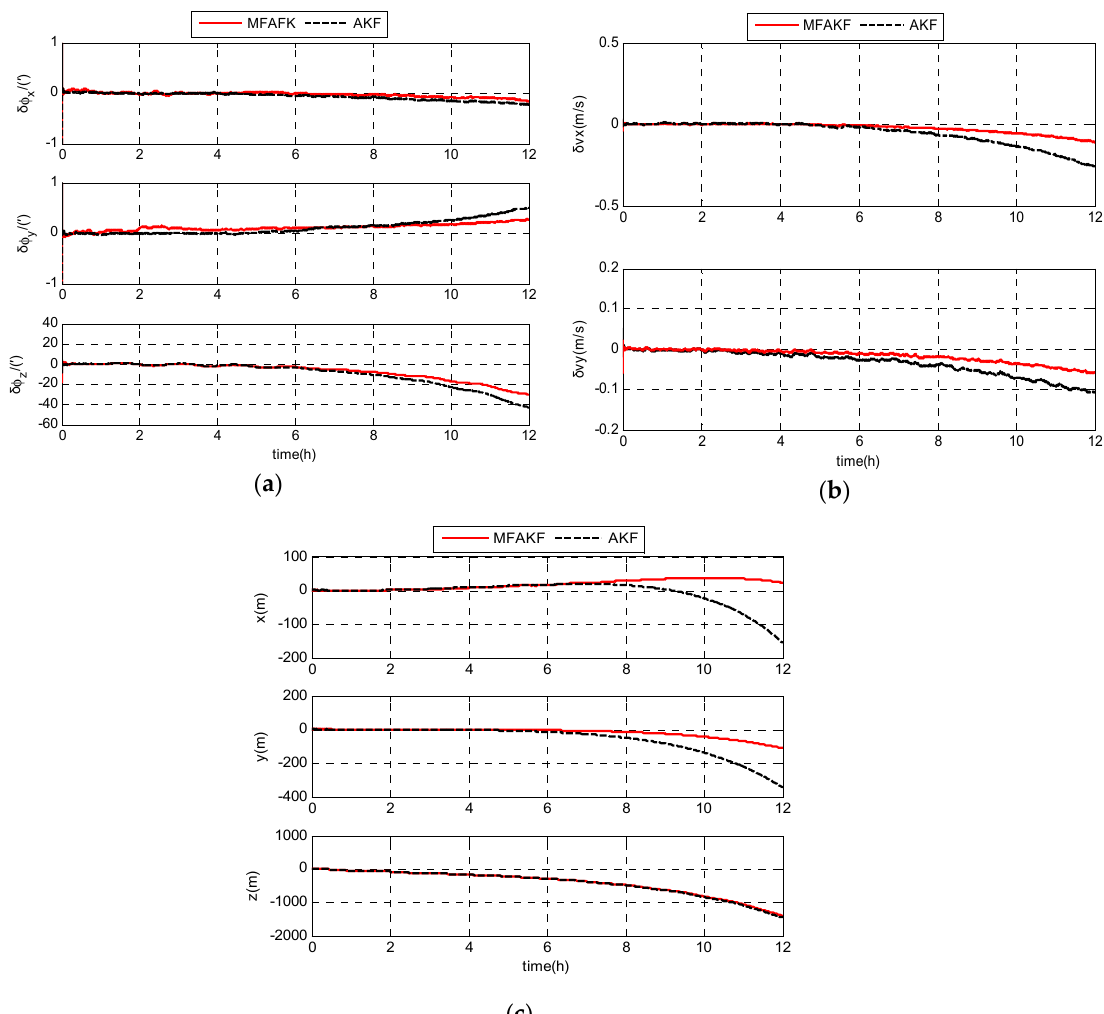
Figure 9. Experimental results of SODINS based on MFAKF and AKF: ( a ) estimation errors of attitude; ( b ) estimation errors of velocity; and ( c ) estimation errors of position.